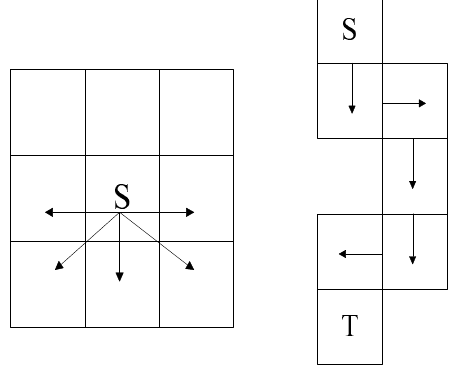
Figure 7. Regional growth method diagram.